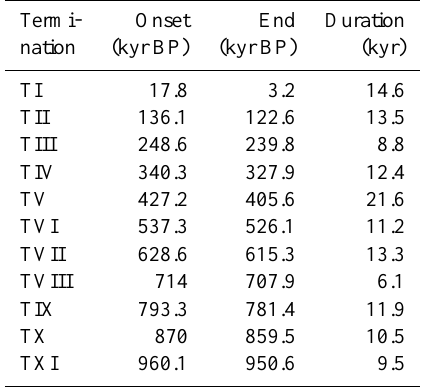
Table 1. Values of model parameters for the different experiments described in this study.